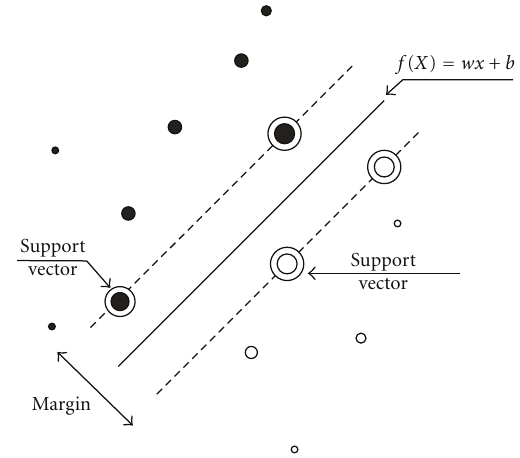
Figure 2: Separable hyperplane between two